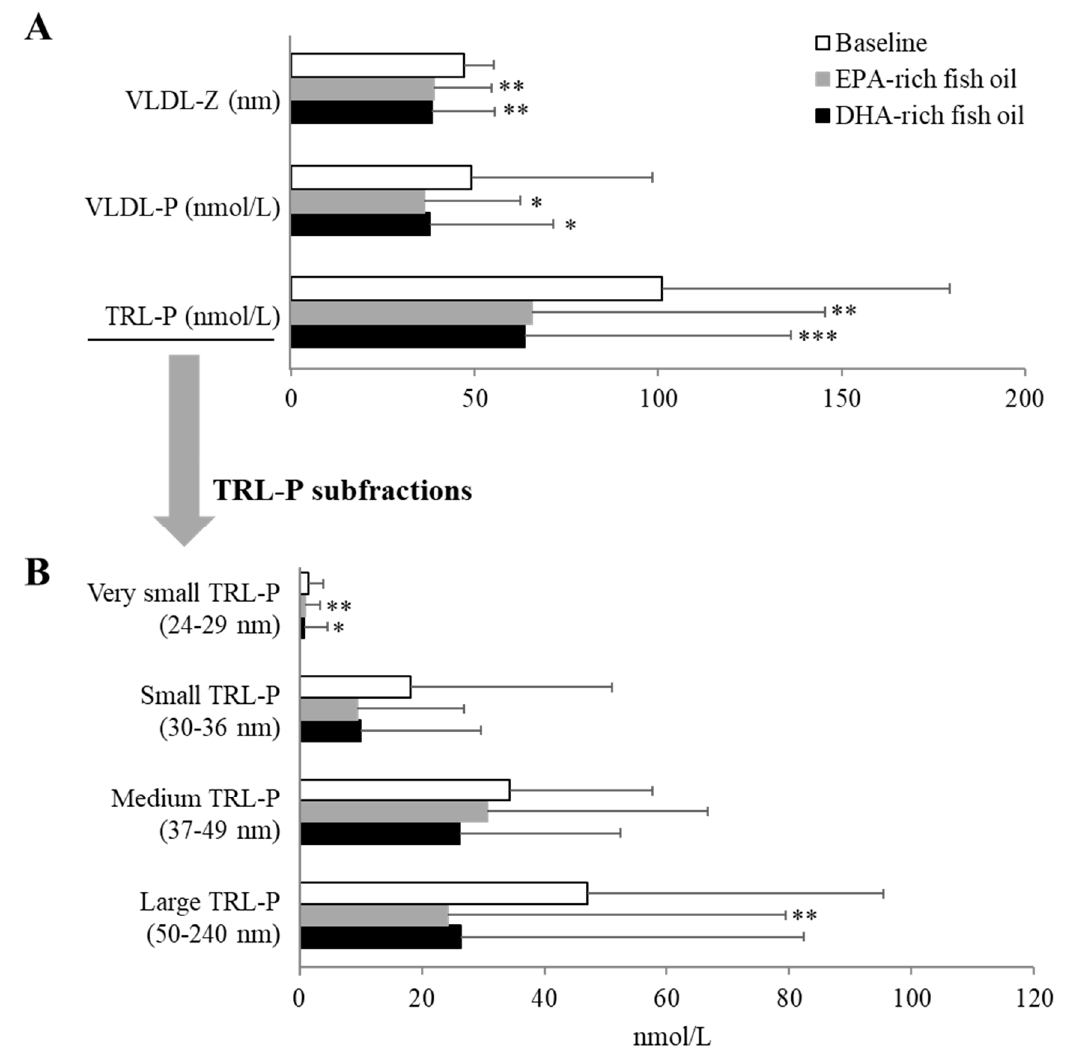
Figure 2. Changes in VLDL particle size / number and overall TRL-P number ( A ), and TRL-P subfraction number ( B ) after an 8-week dietary supplementation with EPA-rich or DHA-rich fish oils. VLDL-Z: VLDL particle size; VLDL-P: VLDL particle number; TRL-P: TG-Rich Lipoprotein particles. Data represented as mean ± SD (n = 30). * p < 0.05, ** p < 0.01, and *** p < 0.001 compared with baseline.